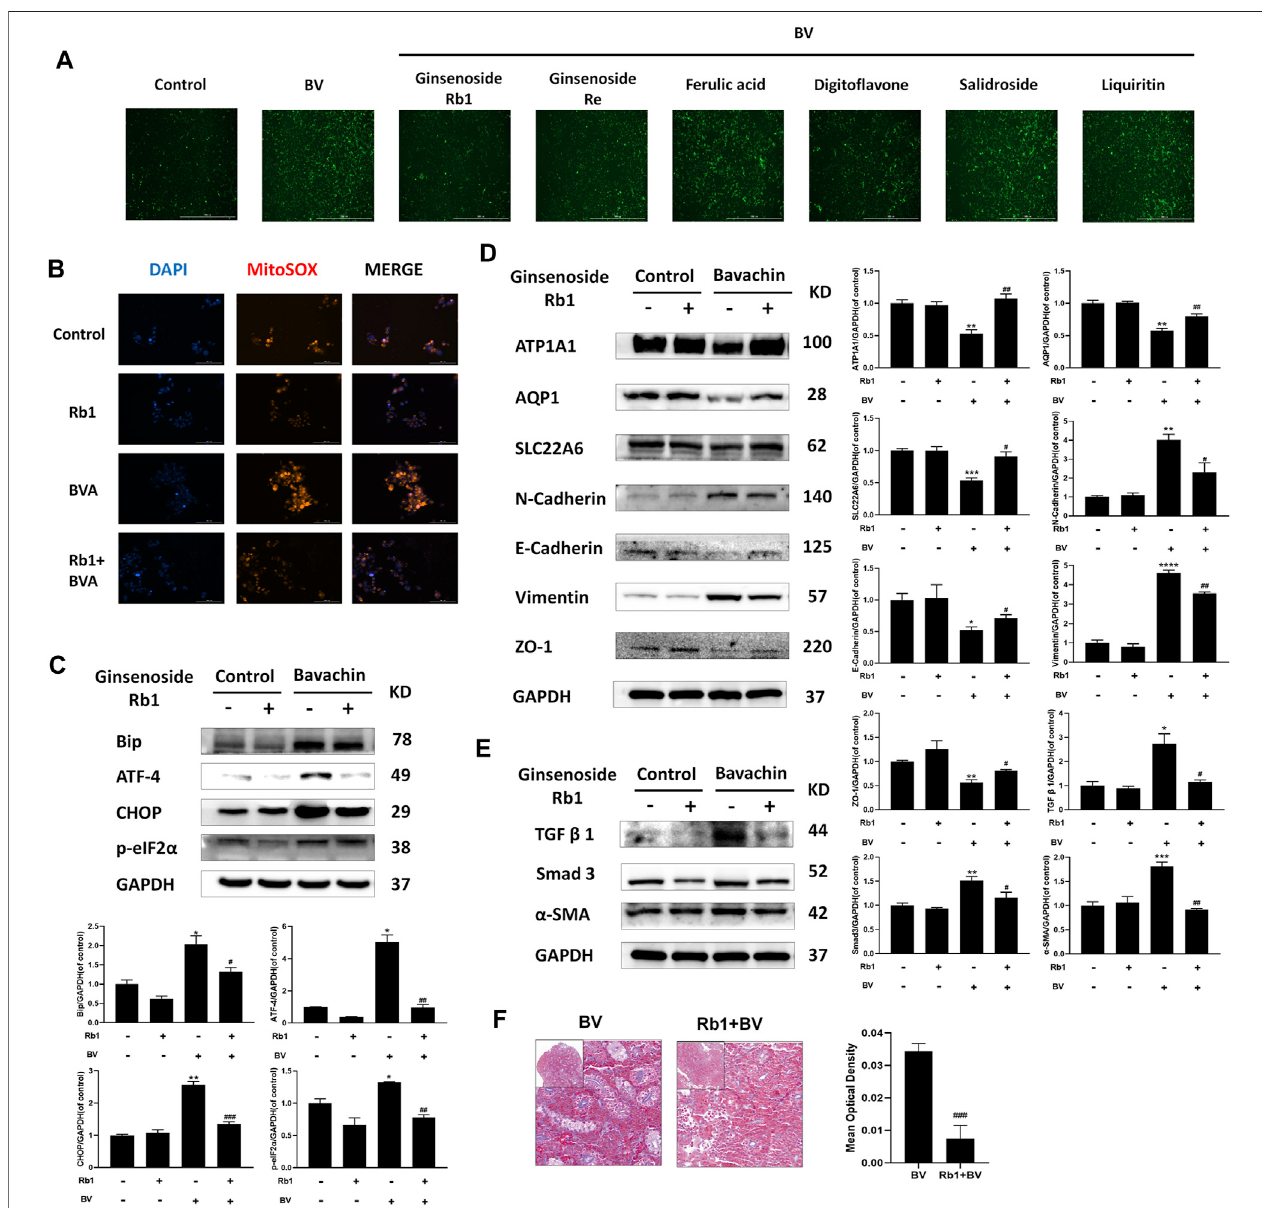
FIGURE 5 | Ginsenoside Rb1 alleviated BV-induced EMT and renal fi brosis by downregulating ROS-mediated ER stress. (A) Screening for the drug inhibiting intracellularCa 2+ release. (B) AfterginsenosideRb1cotreatment,theROSlevelsineachgroupweredetected(scalebar:100 μ m).Theindicatedproteinsparticipatingin ER stress (C) , EMT (D) , and fi brosis (E) in HK2 cells cotreated BV with/without ginsenoside Rb1. (F) Masson trichrome staining of zebra fi sh kidney cotreated BV with/ without ginsenoside Rb1. * p < 0.05, ** p < 0.01, and *** p < 0.001 vs. the control groups. # p < 0.05, ## p < 0.01, and ### p < 0.001 vs. the BV-treated groups.